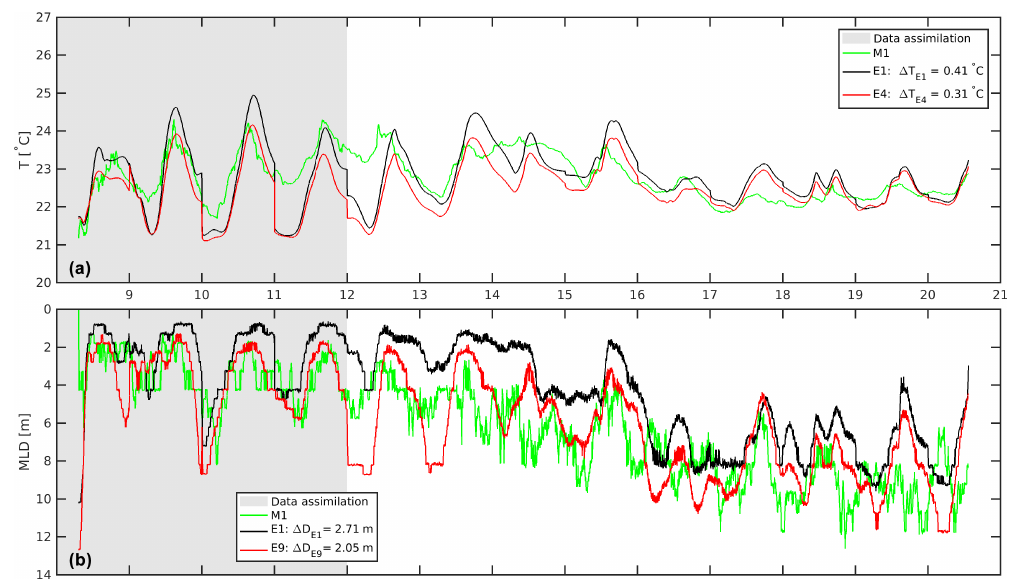
Figure 20. The time series of (a) the near-surface temperature at 0.81m of depth from E1 and E4, (b) the mixed-layer depth (MLD) from E1 and E9, and the corresponding observations at mooring M1. The numbers on the abscissae indicate June dates. The period for which the data are assimilated is highlighted with grey shading.